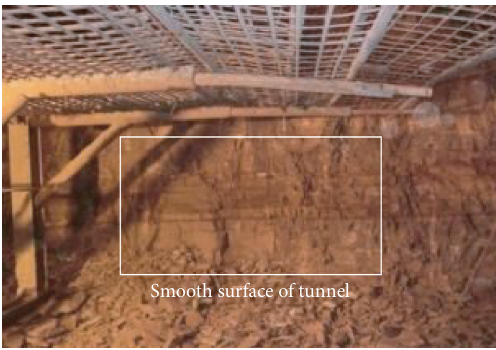
Figure 11: Effect of V-cut blasting with auxiliary